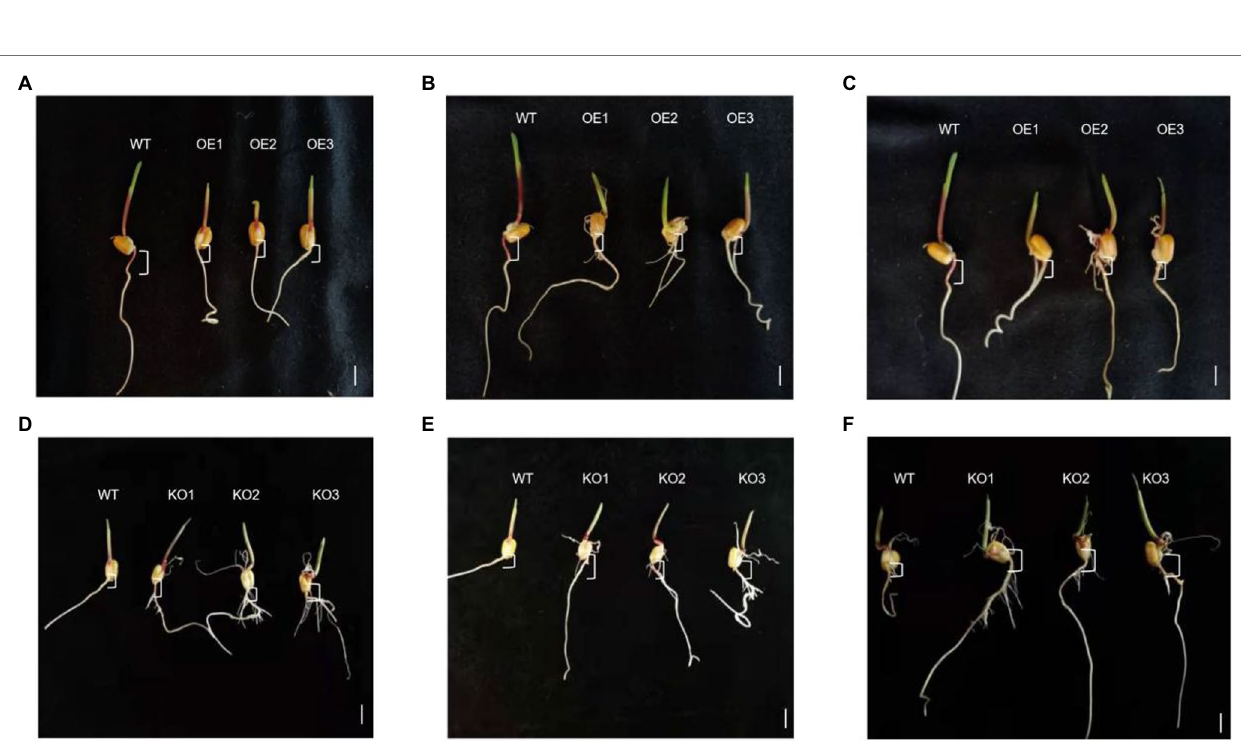
FIGURE 11 | Hypocotyls of transgenic positive plants and WT under LD. (A) represents the comparison of ZmTOC1b overexpressing positive shoots with WT hypocotyls. (B) represents the comparison of ZmPRR73 overexpressing positive shoots with WT hypocotyls. (C) represents the comparison of ZmPRR95 overexpressing positive shoots with WT hypocotyls. The positive seedlings knocked out of ZmTOC1b in (D) generation were compared with WT hypocotyls. The positive seedlings knocked out of ZmPRR73 in (E) generation were compared with WT hypocotyls. The positive seedlings knocked out of ZmPEE95 in (F) generation were compared with WT hypocotyls. Scale bars (A–C) = 5 mm, (D–F) = 1